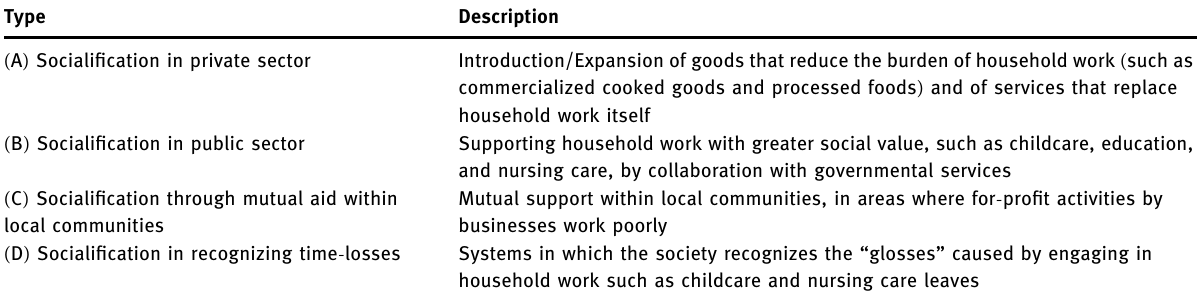
Table 4: Four categories of socialization of household work Type